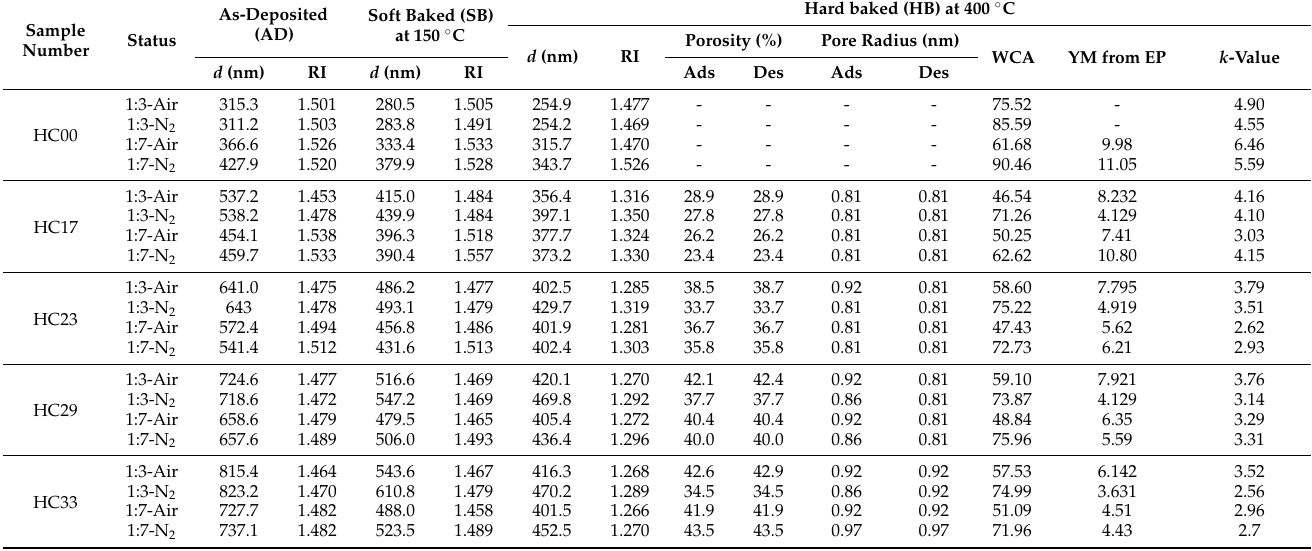
Table 2. Characteristics of porous OSG films with two different benzene bridge group ratios (135TTEB:13BTEB = 1:3 and 1:7) and different porogen concentrations (0 to 41 wt%, sample numbered from HC00 to HC41). The films were as-deposited (AD), soft baked (SB) at 150 ◦ C for 30 min in both air and N 2 ; and hard baked (HB) for 30 min in air and 60 min in N 2 . The two molar ratios of materials are leveled as 1:3-Air and 1:7-Air (air-cured) and 1:3-N 2 & 1:7-N 2 (N 2